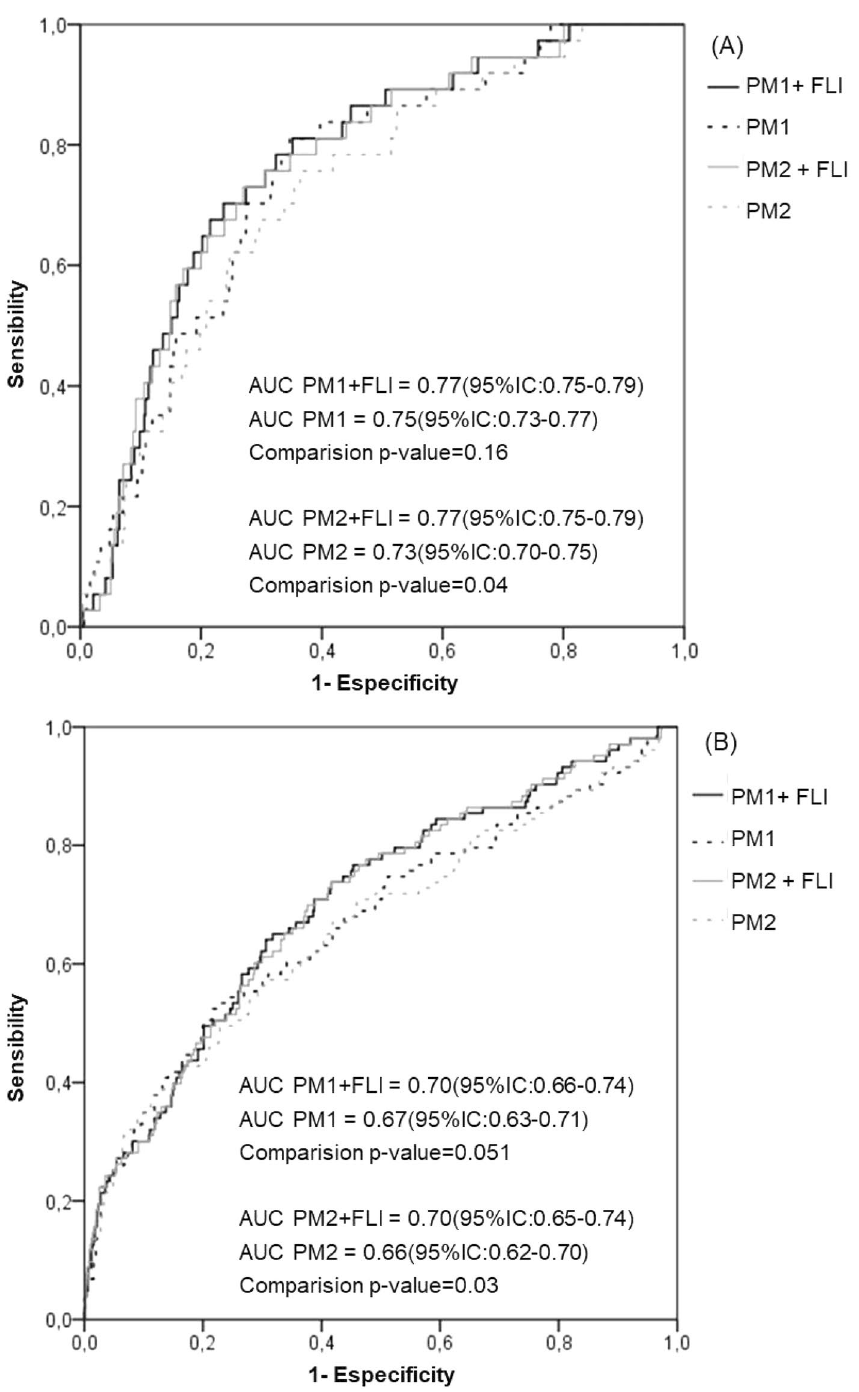
Figure 2. Comparison of area under the receiver-operating characteristic curve (AUC) for incident T2DM in subjects with and without prediabetes according to adding or not FLI to the conventional T2DM prediction risk models PM1 (age, sex, family history of T2DM, fasting glucose level and insulin resistance risk category) and PM2 (age, sex, family history of T2DM and fasting glucose